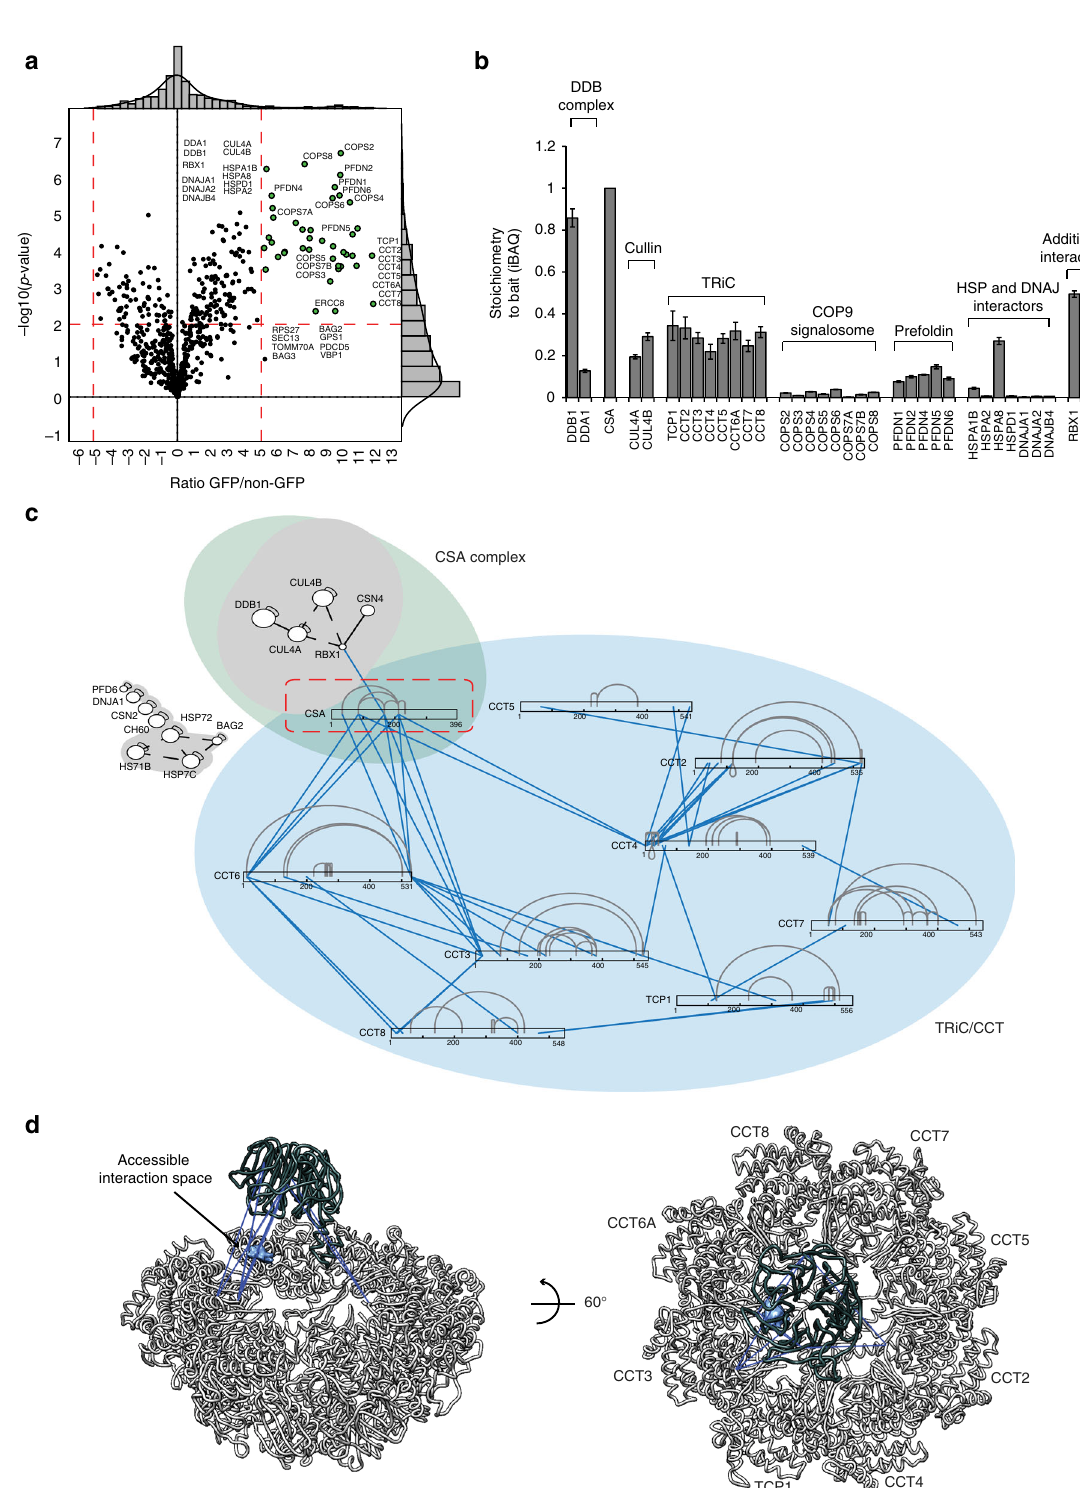
Fig. 2 xIP-MS reveals that CSA interacts with the TRiC inner pocket. a LFQ analysis after CSA-GFP pulldown indicates that all TRiC subunits interact with CSA even after stringent washing. Ratio of protein signal in GFP vs. non-GFP pulldowns is plotted on the x -axis, and the signi fi cance of the difference, − log p -value), is plotted on the y -axis. Cutoffs are selected such that no protein signi fi cantly interacted with the non-GFP control beads. b iBAQ-based 10 ( stoichiometry of selected interactors relative to the bait protein (CSA), which was set to 1. c Cross-linking map of all identi fi ed residue linkages. TRiC subunits are displayed in linear form with intra-links indicated in gray. The presence of ambiguous linkages (where multiple subunits have the same peptide) is indicated by dashed lines. Inter-protein linkages are indicated in blue. d CSA inter-protein linkages with the TRiC octamer (colored light gray) indicate that CSA binds the TRiC inner pocket. Inter-protein cross-links are colored dark-blue. CSA (colored dark gray) was positioned manually to give a visual interpretation to possible CSA-TRiC interactions. The accessible CSA interaction space satisfying 10/11 inter-protein cross-links is shown as a light blue